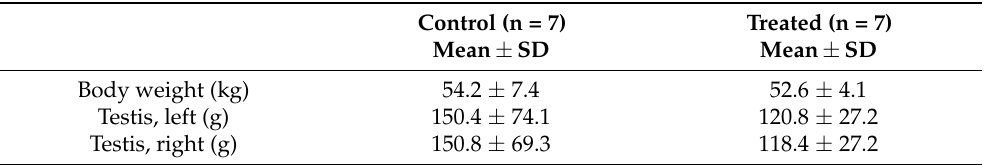
Table 1. Mass measurements of final body weights and testis weights of rams in the control group and the treated group exposed to 25 µ g of BPA per kg of body weight per day. The mean values and standard deviations (SD) are reported.